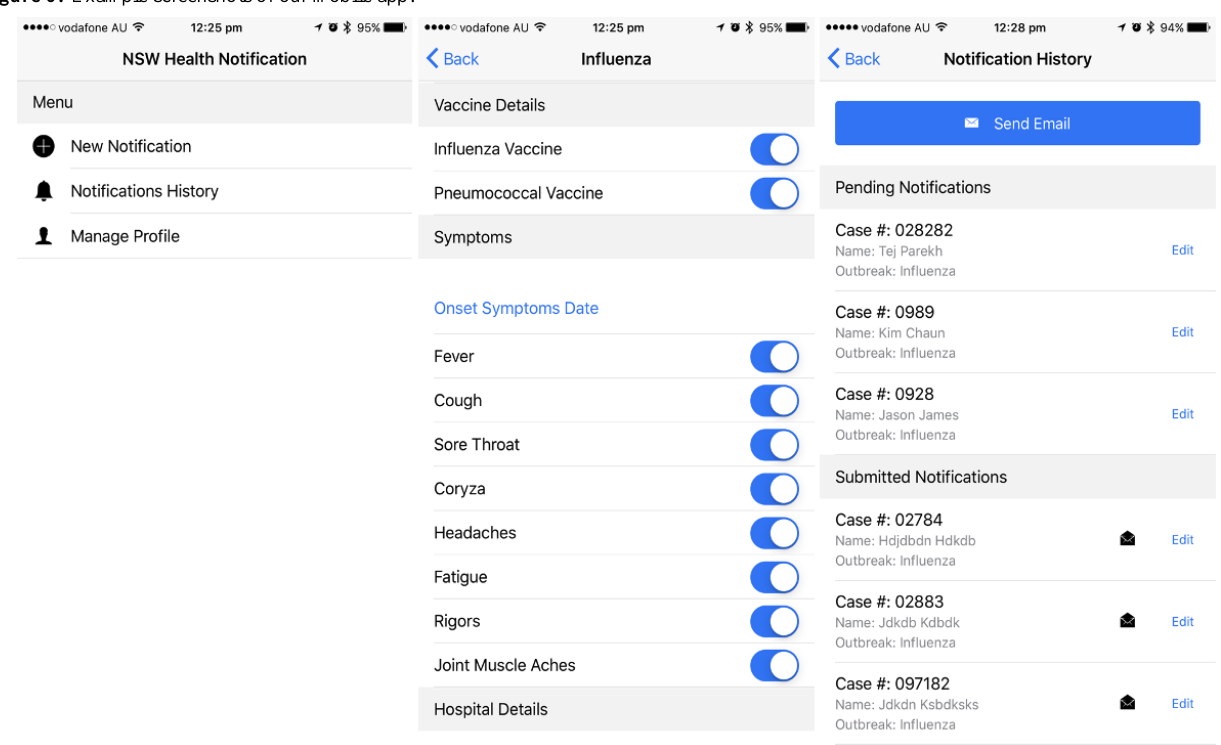
Figure 6. Example screenshots of our mobile